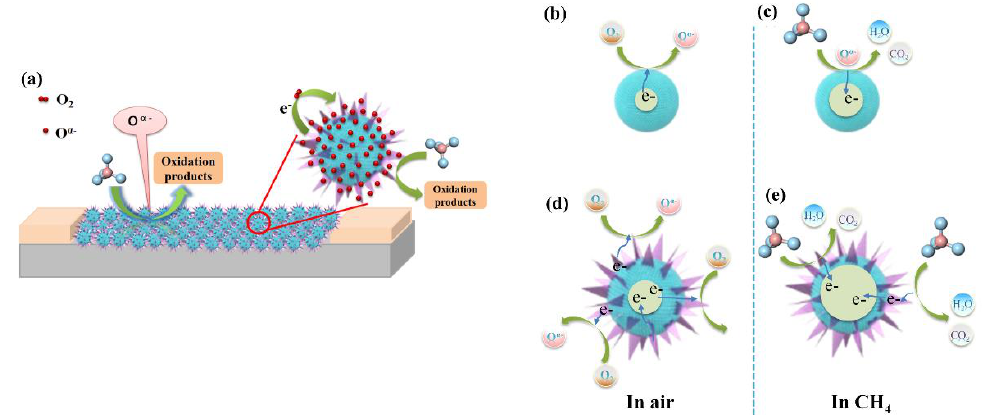
Figure 9. Schematic of the CH 4 sensing mechanism ( a ) and changes in electronic structure for 48-In 2 O 3 ( b – e ). 48-In 2 O 3 ( b – e